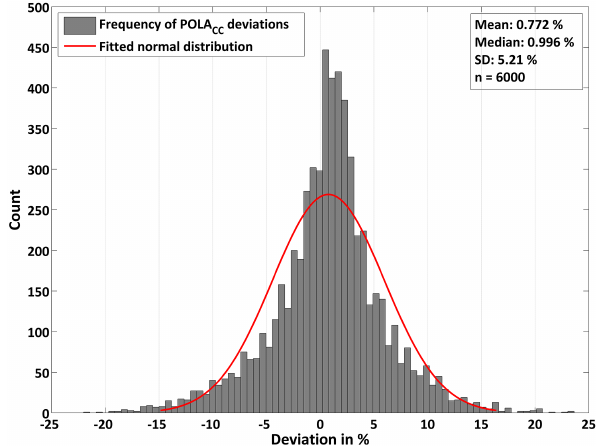
Figure 3. Histogram of coverage-corrected polynya area (POLA CC ) deviations, based on six near-clear-sky case stud- ies from January 2009 (DOY: 002, 020, 024, 025, 026, 030). For each case study, the coverage correction was repeated several times ( n = 1000 × 6), after randomly removing 45% of the pixels within the applied polynya mask.The red curve illustrates a fitted normal